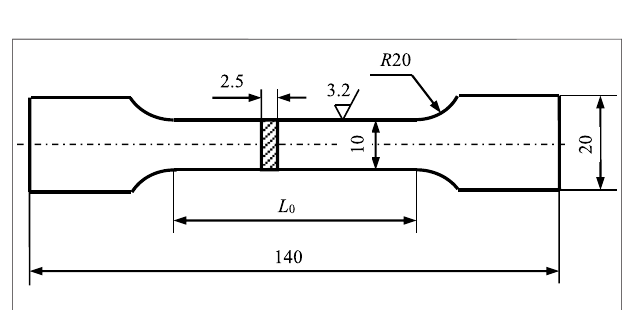
FIGURE 5 | Flat tensile